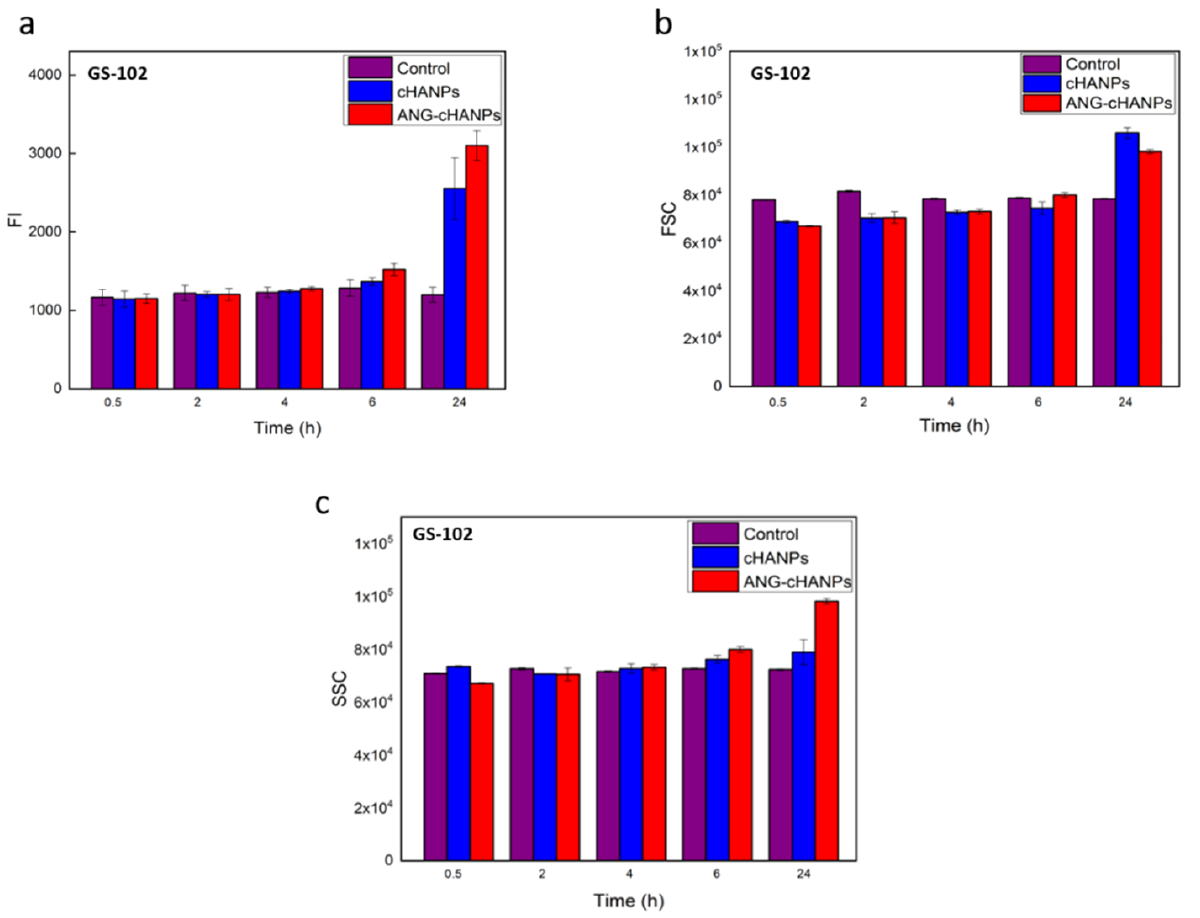
Figure 6. Quantitave uptake of NPs by GS-102 cells in flow cytometry. ( a ) Fluorescence intensity (FI) of GS-102 after incubation with cHANP and ANG-cHANPs; ( b ) Forward scattering (FSC) of GS-102 cells after incubation with cHANPs and ANG-cHANPs ( c ) Side scattering (SSC) of GS-102 cells after incubation with cHANPs and ANG-cHANPs.